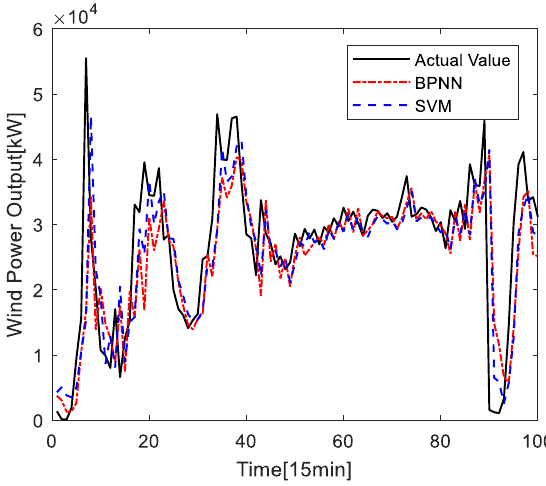
Figure 11. Prediction results of wind power output in the No. 1 power system.